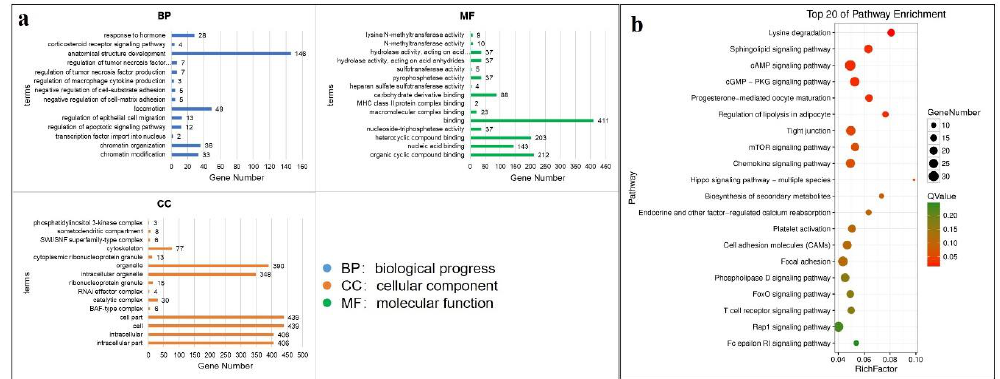
Figure 6. The top gene ontology (GO) and KEGG enrichment analysis. ( a ) The top 15 GO enrichment analysis of di ff erential expressed genes (DEGs). ( b ) The top 20 KEGG enrichment analysis of